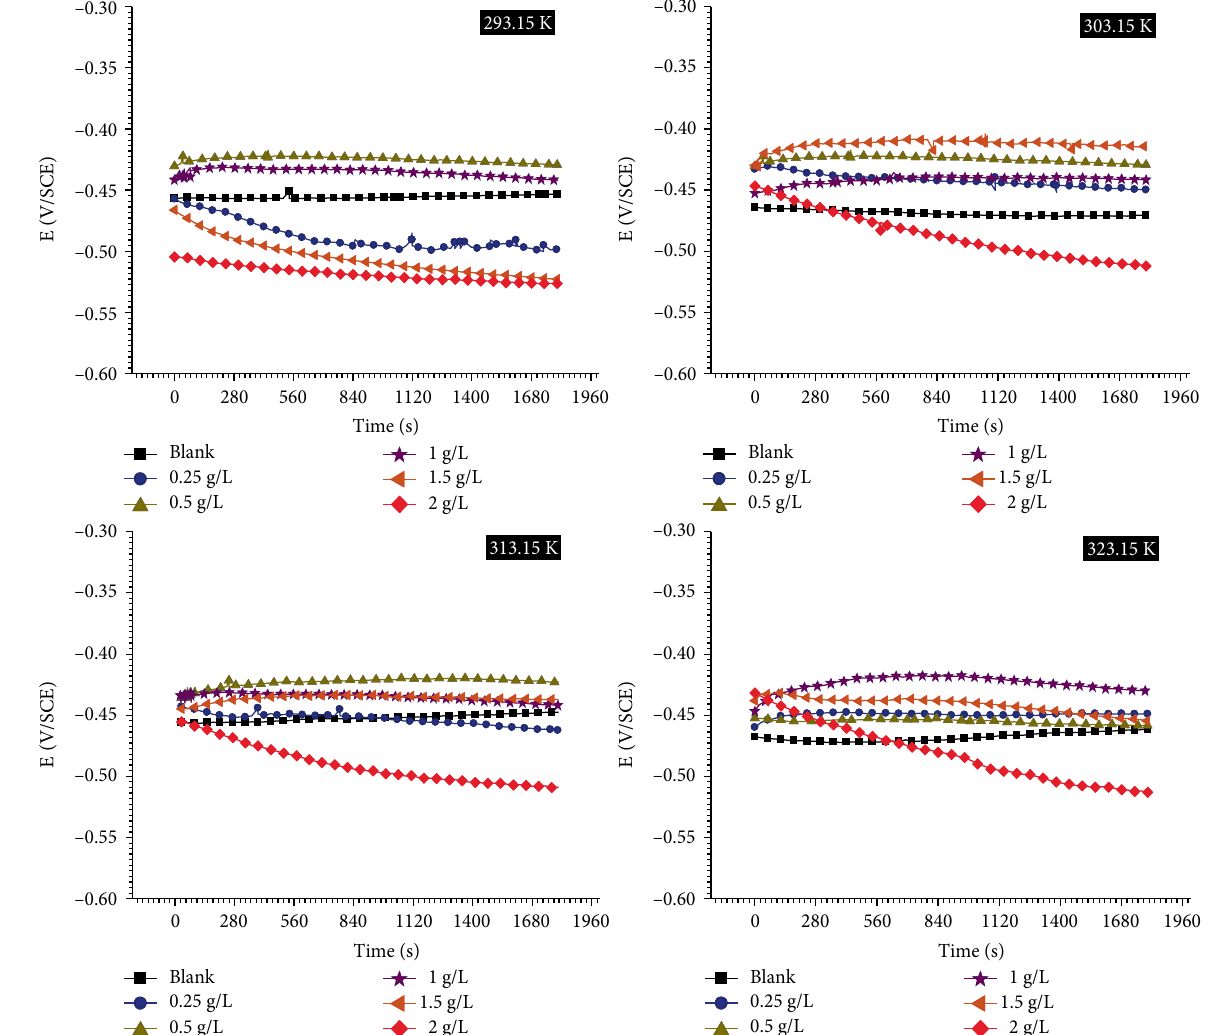
Figure 1: The evolution of open circuit potential ( E